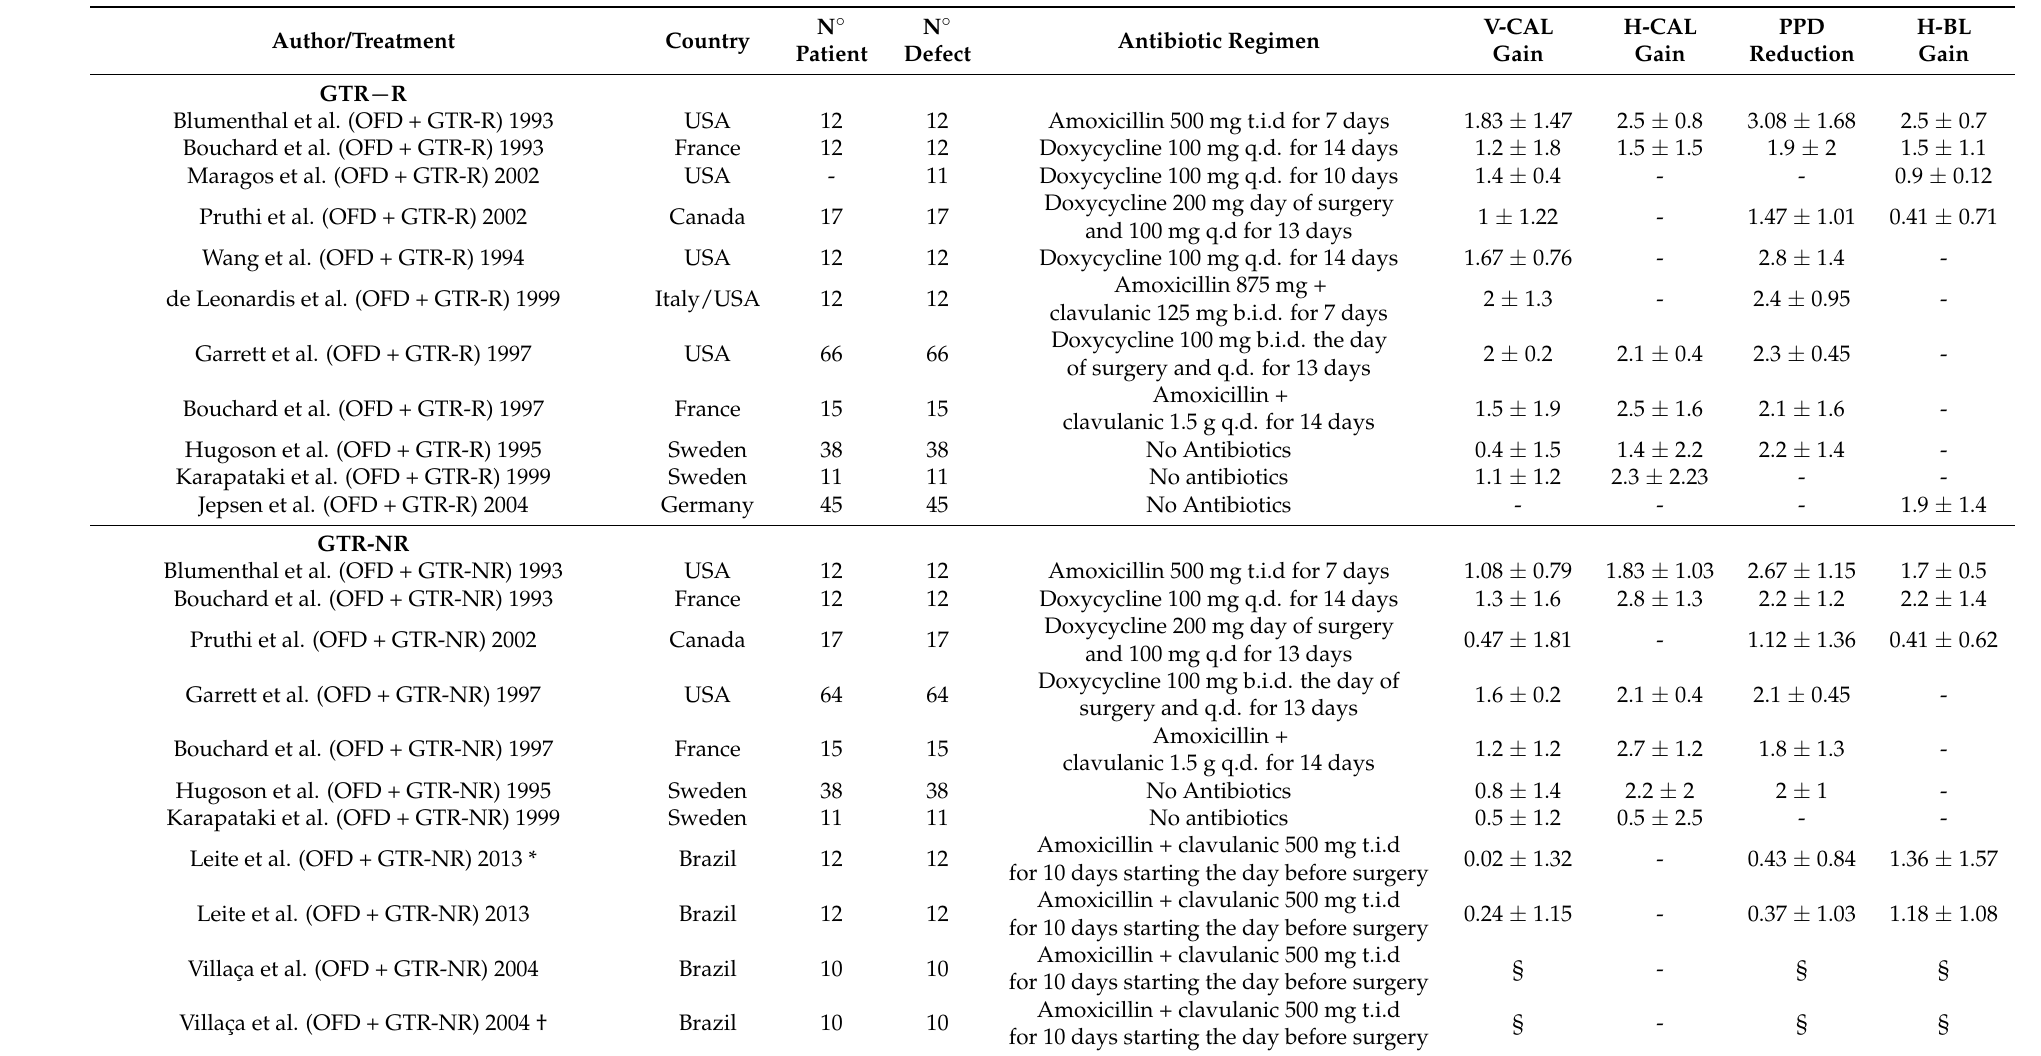
Table 2. Characteristics of the treatment arms from included studies treating furcation